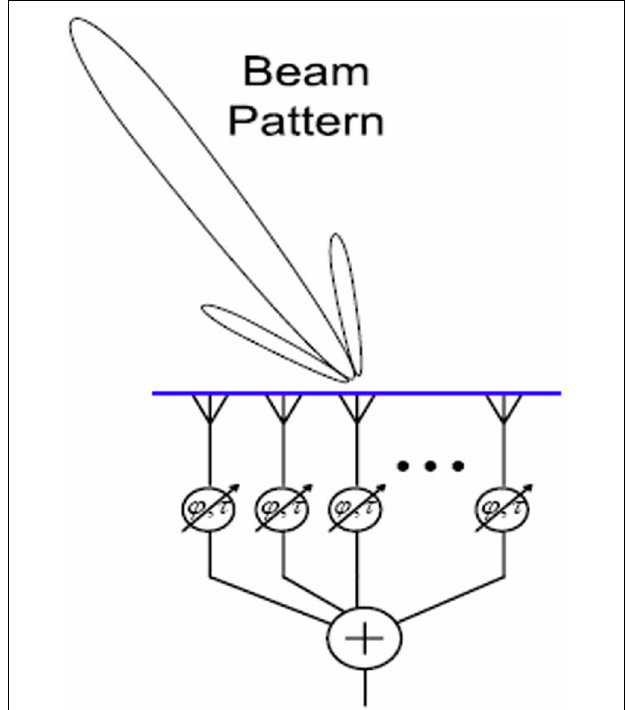
FIGURE 1 | A schematic depiction of beamforming. The angle of arrival to which the array is tuned is represented by the “beam” projected onto space. This may be steered by adding delays at the integration step, or by physically turning the array.